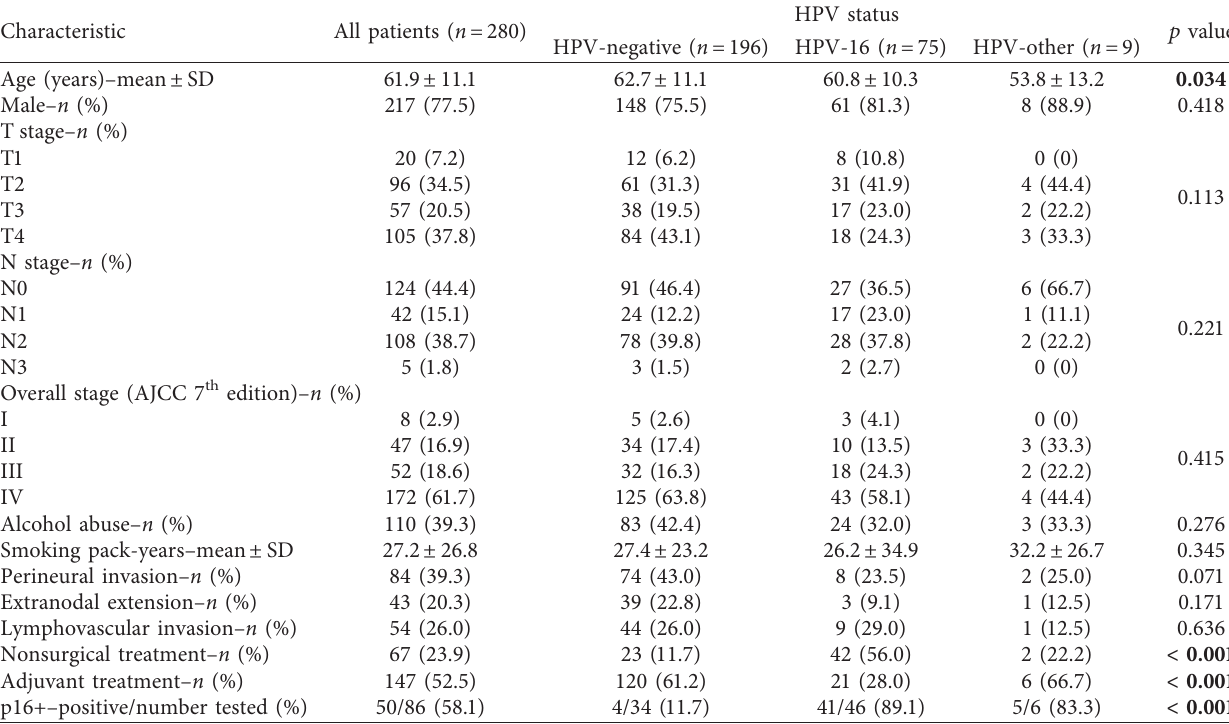
Table 1: Baseline patient and tumor characteristics stratified by HPV status ( n � 280).